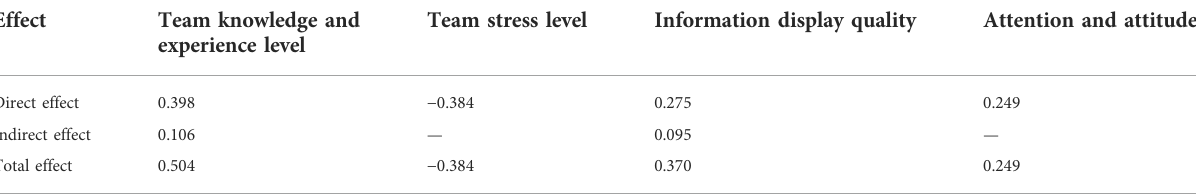
TABLE 3 Effects of various factors on